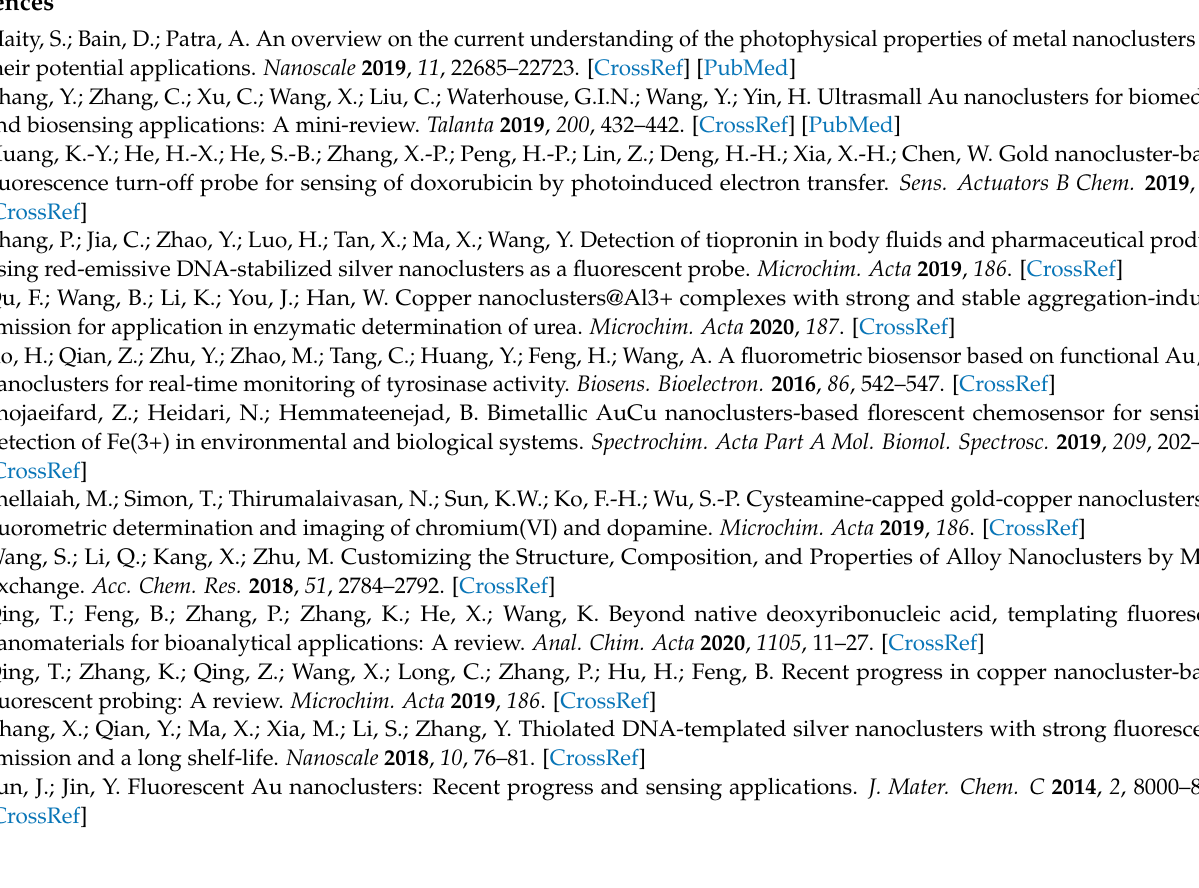
paraquat. Figure S2. Time-resolved fluorescence spectra of GSH/ β -CDs-AuNCs in the (A) absence and (B) presence of 500 ng/mL paraquat. Figure S3. Stern–Volmer plot for the fluorescence of GSH/ β -CDs-AuNCs quenched by different concentrations of paraquat. F 0 and F 1 are the fluores- cence intensity of GSH/ β -CDs-AuNCs in the absence and presence of paraquat, respectively. Figure S4. The modification of GSH-AuNCs with (A) different concentrations of SH- β -CDs and (B) under dif- ferent temperatures. Figure S5. Paraquat quenching efficiency on GSH/ β -CDs-AuNCs fluorescence with different incubation times, under incubation condition: 400 rpm, 25 ◦ C. Figure S6. The chemical structure and acidity coefficients of three buffers. Figure S7. (A) The absorbance spectra and (B) chem- ical structures of 10 different pesticides including paraquat, carbofuran, isocarbophos, phosolone, chlorpyrifos, acetamiprid, methonmyl, glyphosate, fenamiphos, and imidacloprid. Table S1: Different spiked samples recovery detection